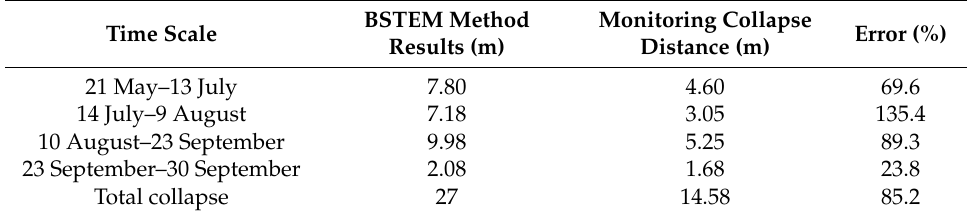
Table 11. BSTEM results, field measurements and errors for surveying Section 1.